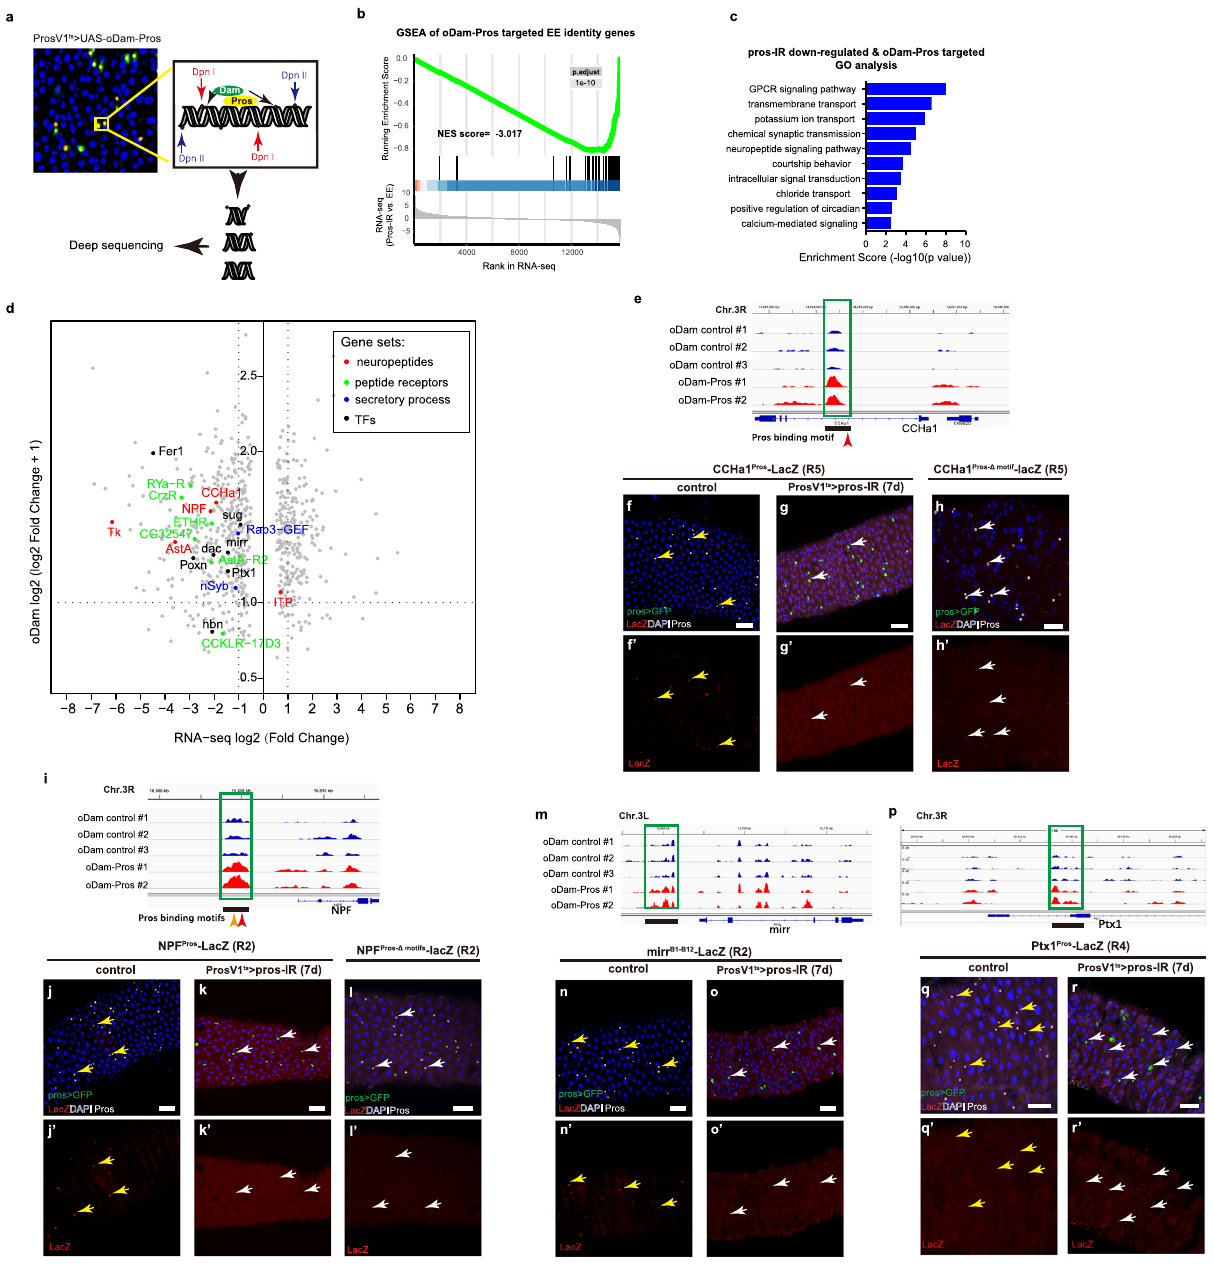
Fig. 2 | Pros globally binds to and regulates the transcription of EE signature genes. a A schematic diagram for Dam-ID analysis to seek for Pros binding sites in EEsofadult fl ies; b GSEAmapofDam-Prostargetsamongtop250EEidentitygenes. Almostallofthesegenesaredown-regulatedupon pros depletion; c GO analysisof genes both targeted by Pros Dam-ID and down-regulated upon pros depletion; d Scatter graph showing multiple EE identity gene sets that downregulated after pros-RNAi were also targeted by Pros, including neuropeptides (orange spots), peptide receptors (green spots), and neuropeptide regulating TFs (purple spots). e Examples showing direct Pros targeting on neuropeptide gene CCHa1, the putativeProstargetingregionandpredictedProsbindingmotifarelabeled;ALacZ reporter driven by the putative Pros binding sequence on CCHa1 locus marks a subset of R5EEs ( f ,yellow arrow heads),and depleting pros byProsV1 ts > pros -RNAi abolishesLacZexpressionentirely( g , white arrowheads),depletingtheconserved Pros binding motif signi fi cantly abolished lacZ activity ( h , white arrow heads);